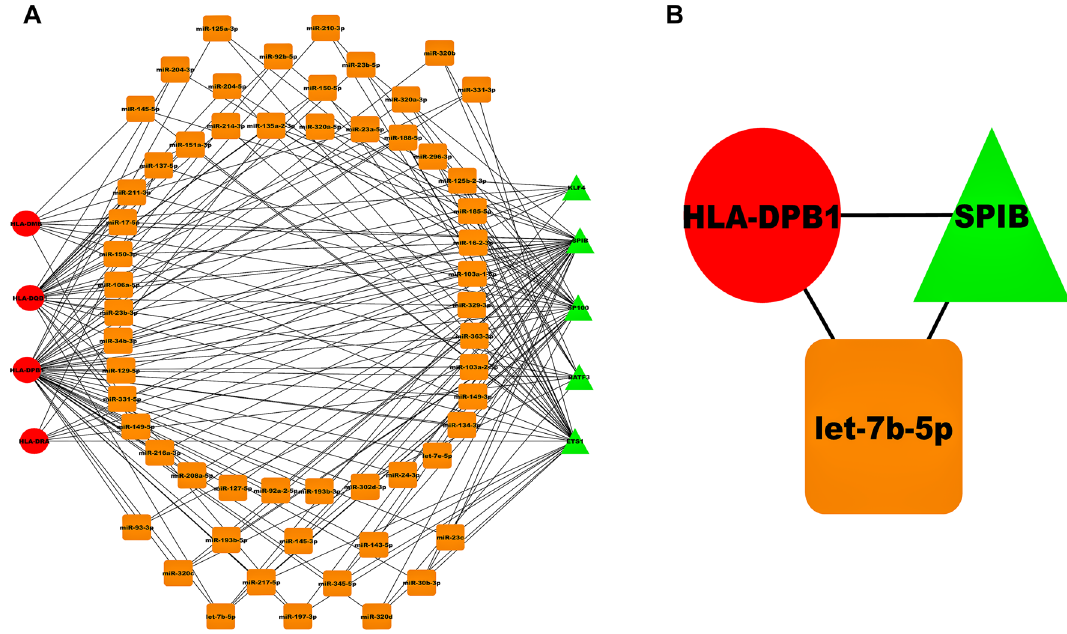
Figure 6. ( A ) Sepsis-specific 3-node miRNA FFL network with 66 nodes and 176 edges. ( B ) The highest-order FFL network motif comprises one hub TF (SPIB), one hub mRNA (HLA-DPB1), and one hub miRNA (let- 7b-5p). Red-colored circular nodes signify hub DEGs, green-colored triangular nodes signify TFs, and golden- colored rectangular nodes signify miRNAs.